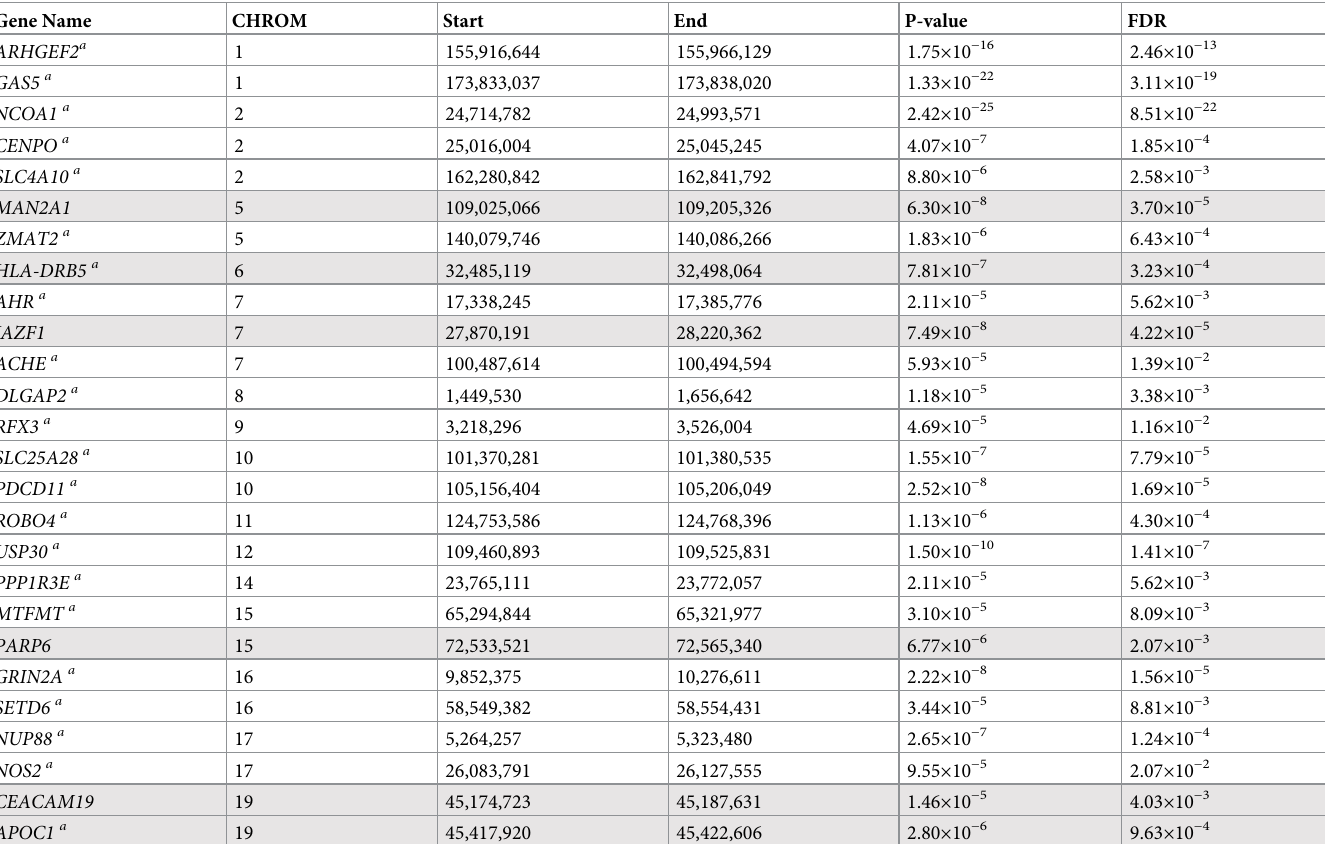
Table 3. Significant genes identified by VC-TWAS using IGAP summary statistics data with BGW cis- and trans- eQTL weights, which are either known GWAS loci or shown to be related with AD or other neurological diseases by previous studies. AD risk genes identified by previous GWAS are shaded in